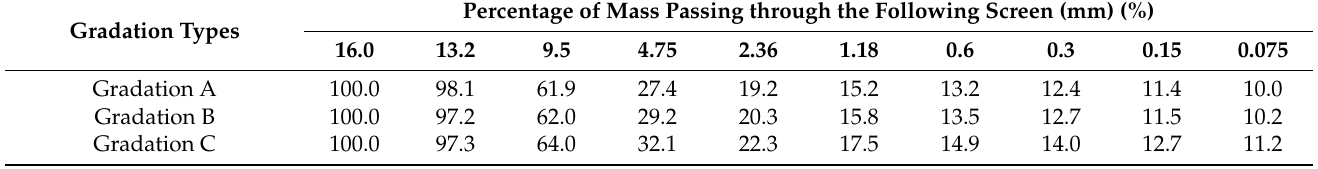
Table 5. The mass percentage of three gradations of mixture through the